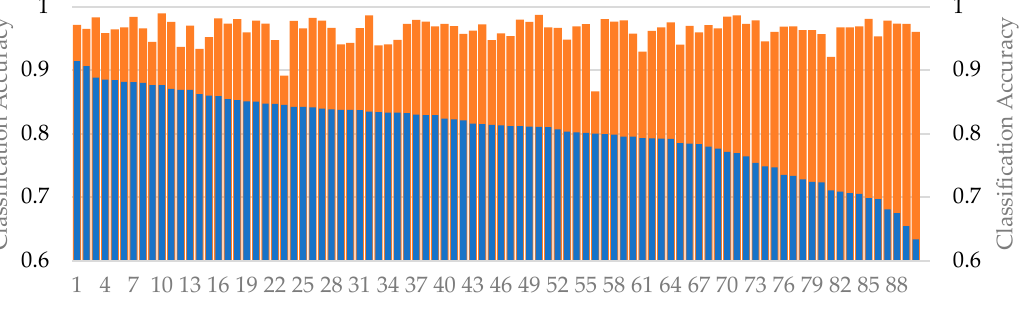
Figure 4. Comparison of the classification accuracy of the model after two normalization methods.